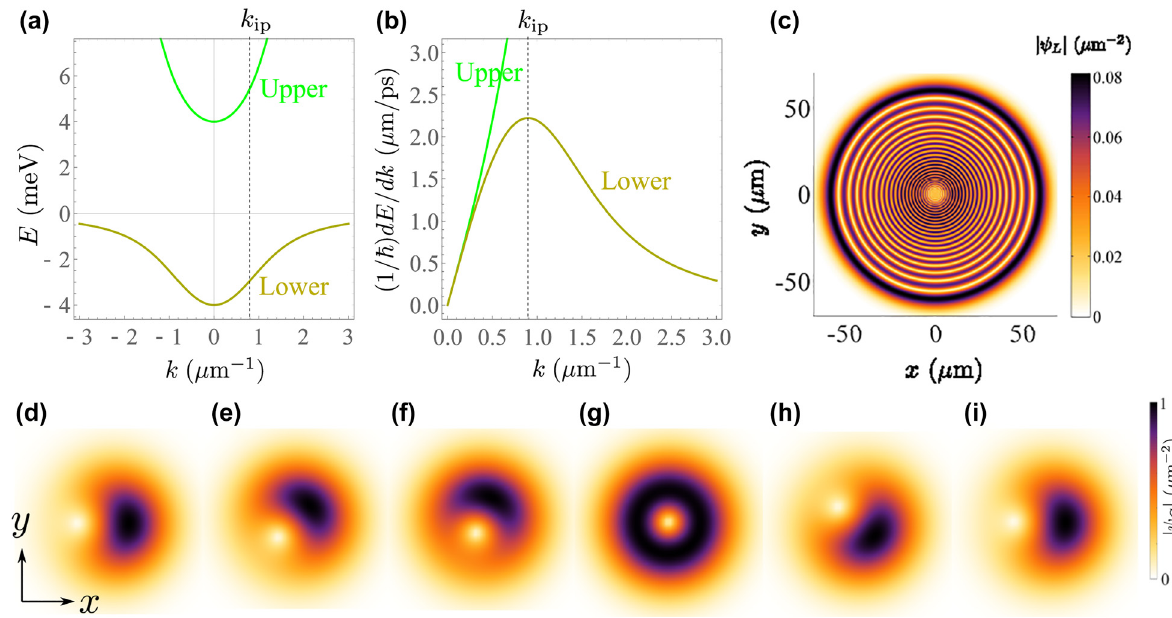
Figure 1: Background concepts. (a) Branchesof exciton – polariton dispersion;the lowerpolariton dispersion, shown indarkyellow,deviatesfrom the parabolic shape for k > k ip . The upperbranch, shown in green, is always almostparabolic. Consideringthe lowerbranch, itsconcavity is upward for k > k ip and is downward for k < k ip ,andasaconsequence k ip isanin fl ectionpoint.(b)Thederivativeofenergy( E )withrespecttowavenumber( k )showsalocalmaximumat the in fl ection point k ip , so thelowerpolariton packetis slowerbeyond k ip . (c)Exampleof self-interfering wavepacketfor the lowerpolariton ( ψ L ), generatedfroma1.5 μ mwideinitialstateandafter200psofdiffusion.Thisregimeisreachedbyexcitingwithamomentumwidthextendingover the in fl ection point of the lower branch, that is by a spatially tight beam, where the fi eld interferes with itself. (d – i) Rabi oscillating motion of a displaced vortex as seen in the photon component of the exciton – polariton fi eld. The vortex core (the point of zero density) makes an entire counter-clockwise rotation during a Rabi cycle.. Here the size of the packet is large enough large in real space so that the wavepacket never straddles the in fl ection